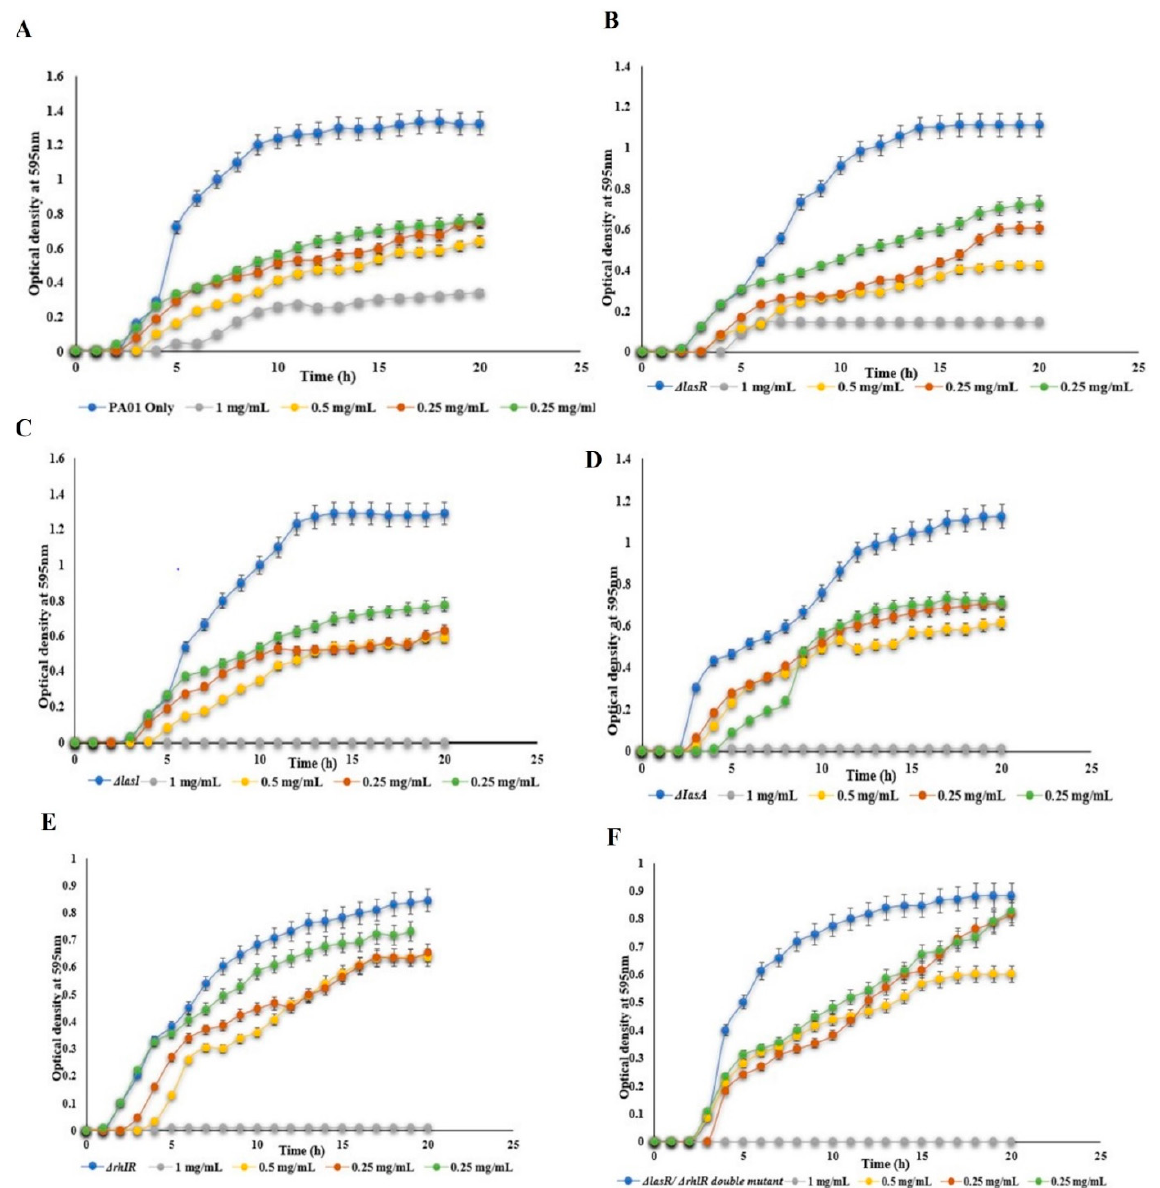
Figure 2. The effect of mBTL- loaded at different concentrations was investigated using ( A ) wild type PA01 and different pseudomonal QS mutants ( B ) PA1430 ( ∆ lasR ), ( C ) PA1432 ( ∆ lasI ), ( D ) PA3477 ( ∆ rhlR ), ( E ) PA1871 ( ∆ lasA) , and ( F ) ( ∆ lasR)/ ∆ rhlR double mutants. All experiment performed three times in triplicate.